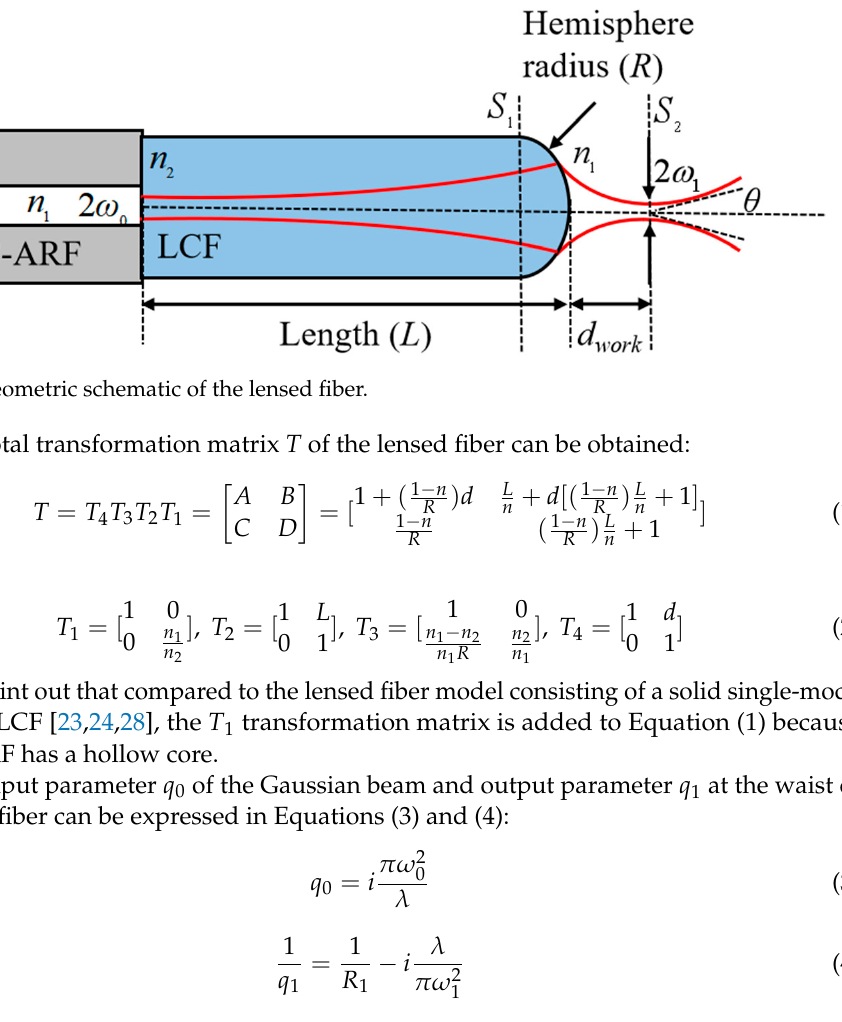
Figure 1. ( a ) Schematic of objective-lens-free fiber-optic TPEM. DM: dichroic mirror. CL: coupling lens. DC-ARF: double-cladding antiresonant fiber. PZT: piezoelectric ceramic tube. BP filter: bandpass filter. FL: focusing lens. PMT: photomultiplier tube. ( b ) Photograph of the 1.6 g integrated probe. ( c ) Photograph of the lensed fiber. ( d ) SEM image of DC-ARF. ( e ) Fiber endface microscopy image of LCF.